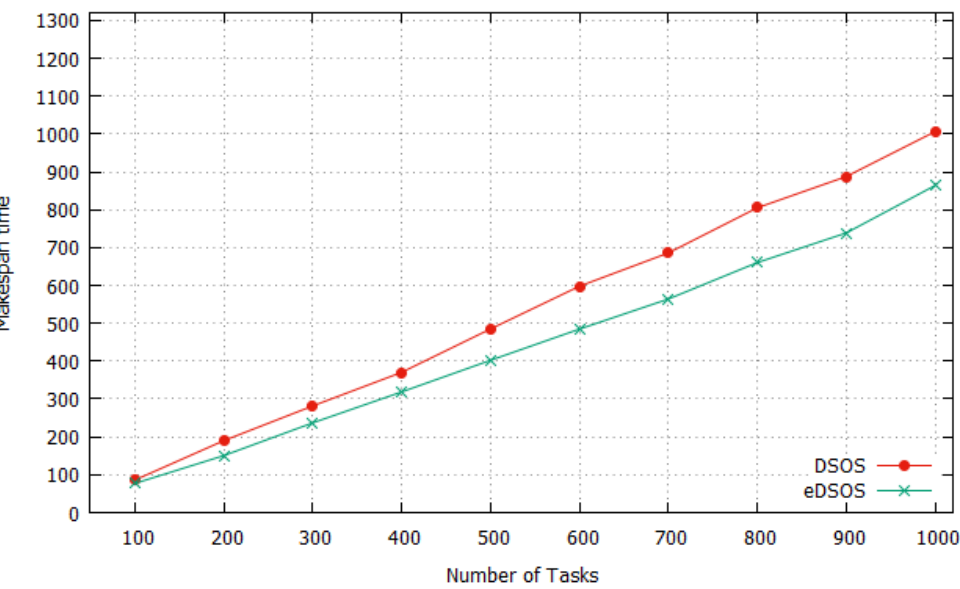
Figure 5. Makespan for dataset with the right-half